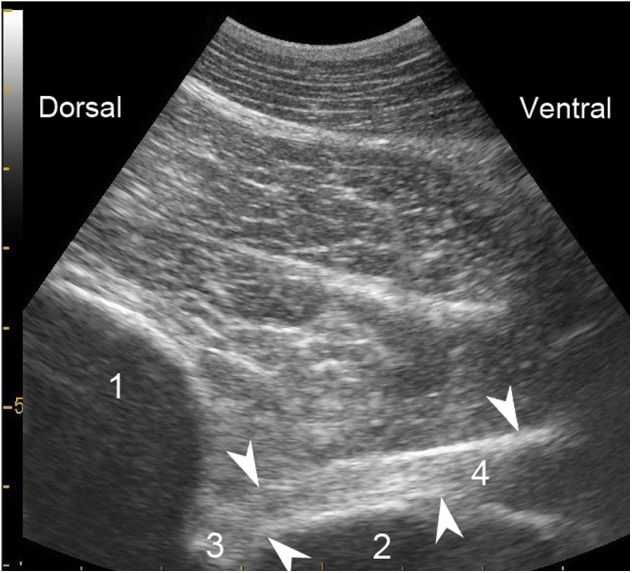
Representative longitudinal ultrasonographic section of C8 ramus ventralis in an equine cadaver. Ventrally to T1 cranial articular process, the nerve trunk (arrows) shows echogenic longitudinal fasciculi bordered by a more echogenic sheath. 1- Cranial articular process of T1; 2- Vertebral body (margin of the fossa) of C7; 3- Intervertebral foramen; 4- Ramus ventralis of C8.